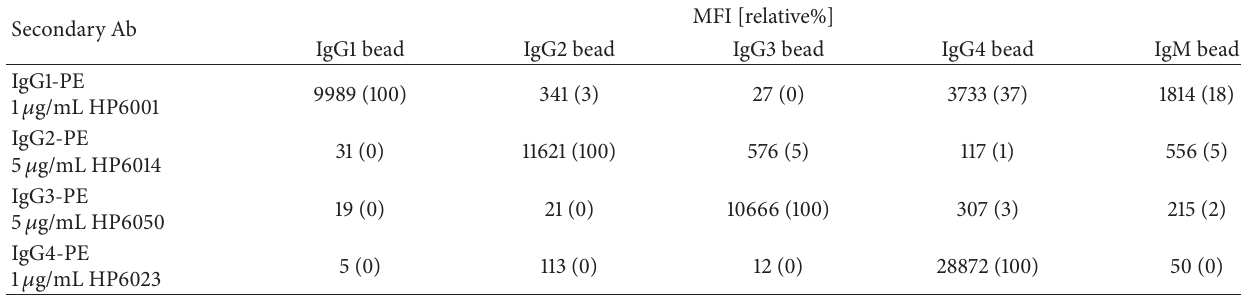
Table 2: PE conjugated secondary antibodies for IgG subclass detection.